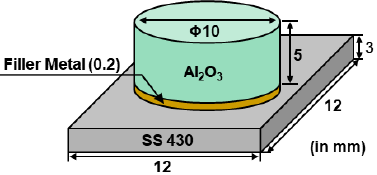
Figure 1. Schematic illustration of the brazed specimen.